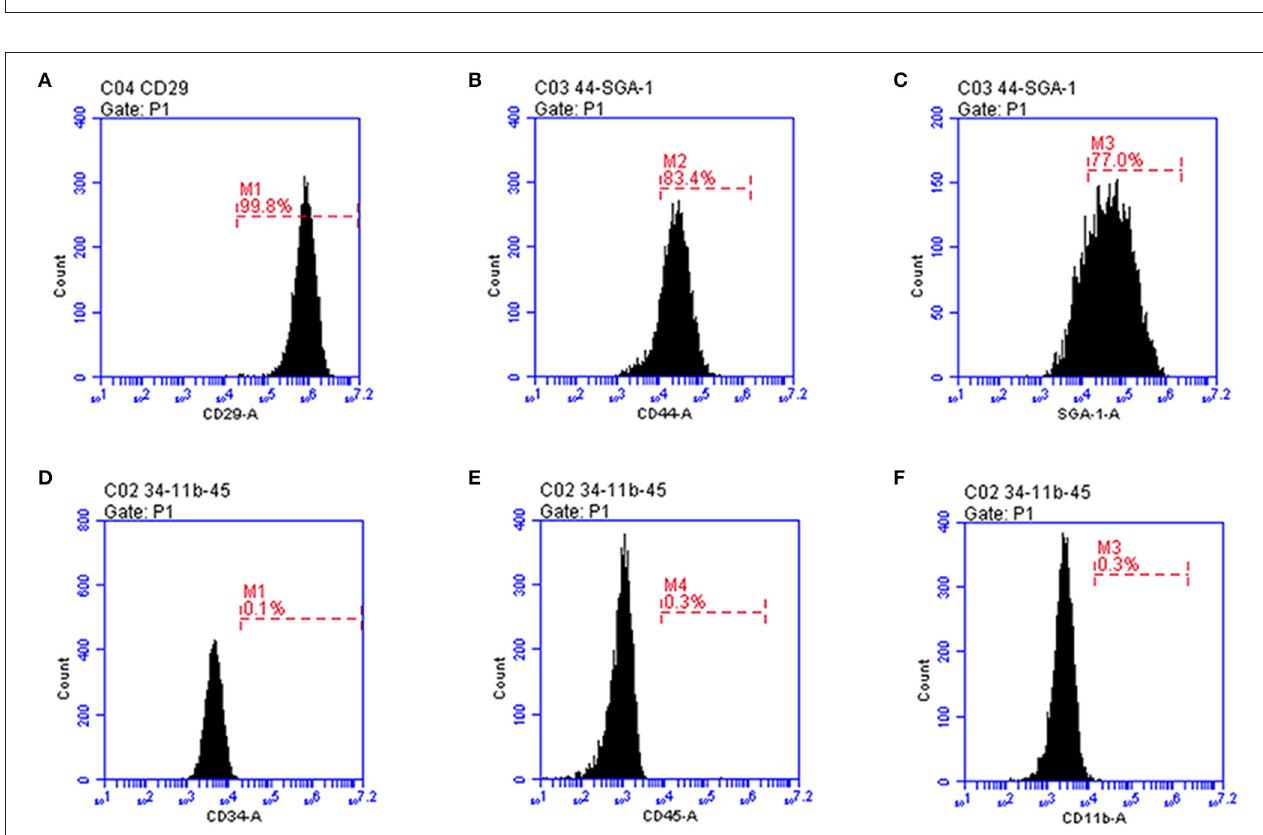
FIGURE 2 | Flow cytometry characterization of MSC expressed markers. (A) CD29; (B) CD44; (C) SGA-1; (D) CD34; (E) CD45; (F) CD11b.